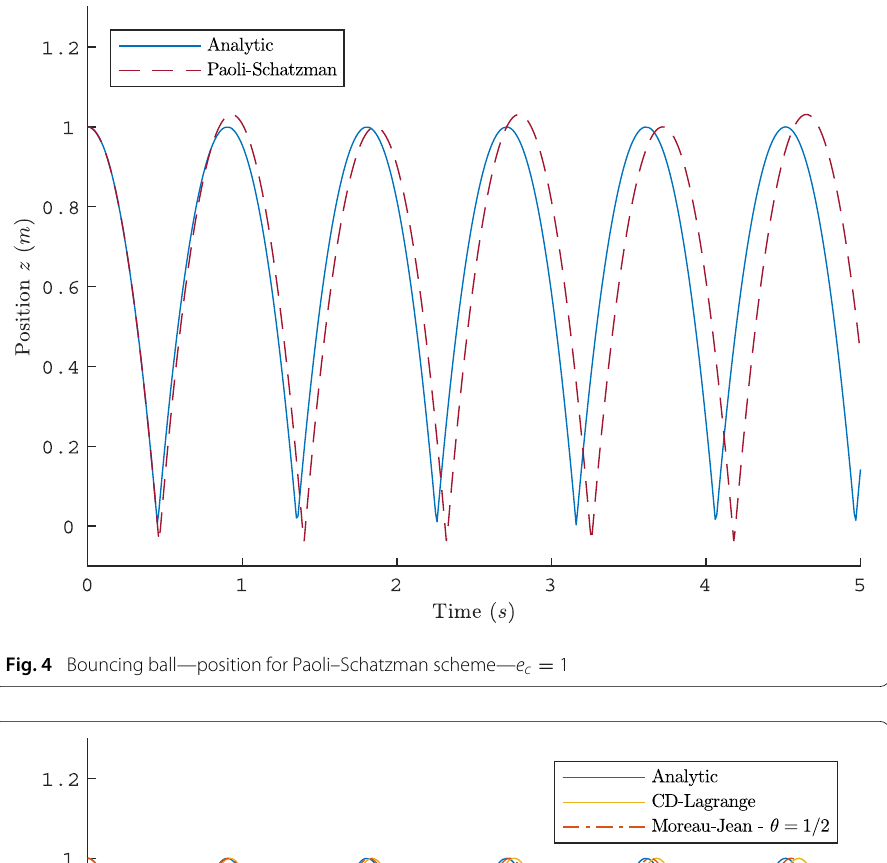
Fig. 4 Bouncing ball—position for Paoli–Schatzman scheme— e c = 1